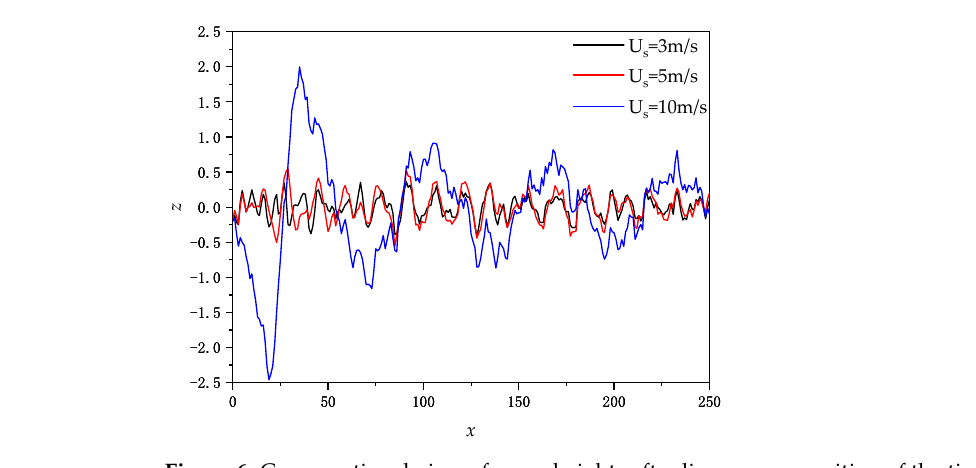
Figure 6. Cross-sectional view of wave heights after linear superposition of the time-varying Kelvin wake and the time-varying sea surface.